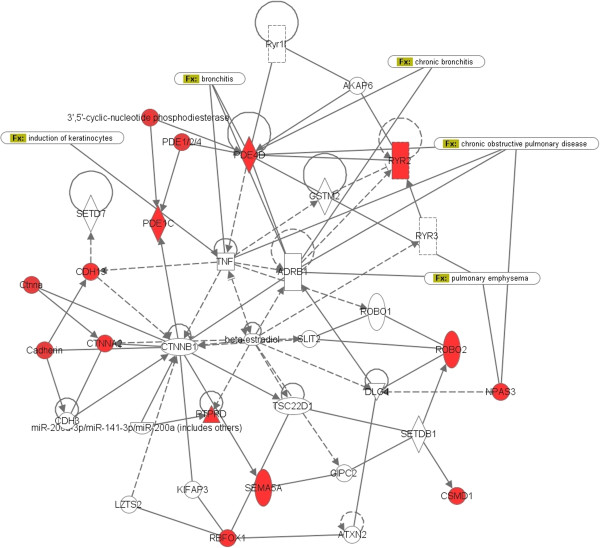
Interactive network of the 11 genes shared among the top 1,000 SNPs of each population. The 11 genes are CDH13, CSMD1, CTNNA2, NPAS3, PDE1C, PDE4D, PTPRD, RBFOX1, ROBO2, RYR2, and SEMA5A. Genes with red nodes represent hub genes in our analysis; others are generated through the network analysis from Ingenuity Pathways Knowledge Base. Edges are displayed with labels that describe the nature of the relationship between the nodes. All edges are supported by at least one reference from the literature or from canonical information stored in the Ingenuity Pathways Knowledge Base. The lines between genes represent known interactions, with solid lines representing direct interactions and dashed lines representing indirect interactions. Nodes are displayed using various shapes that represent the functional class of the gene product.